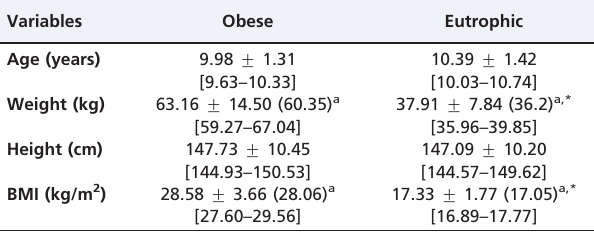
Table 1 - General characteristics of obese and eutrophic